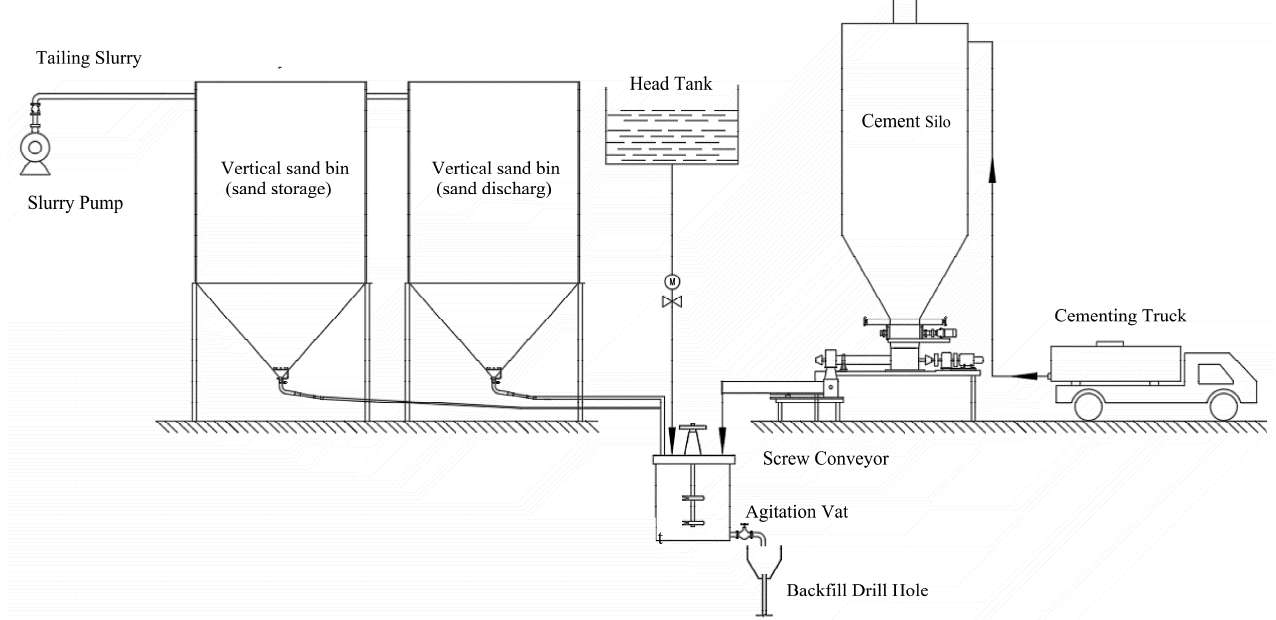
Figure 3. (Source elaborated by authors) Process flow of vertical sand silo backfill system.